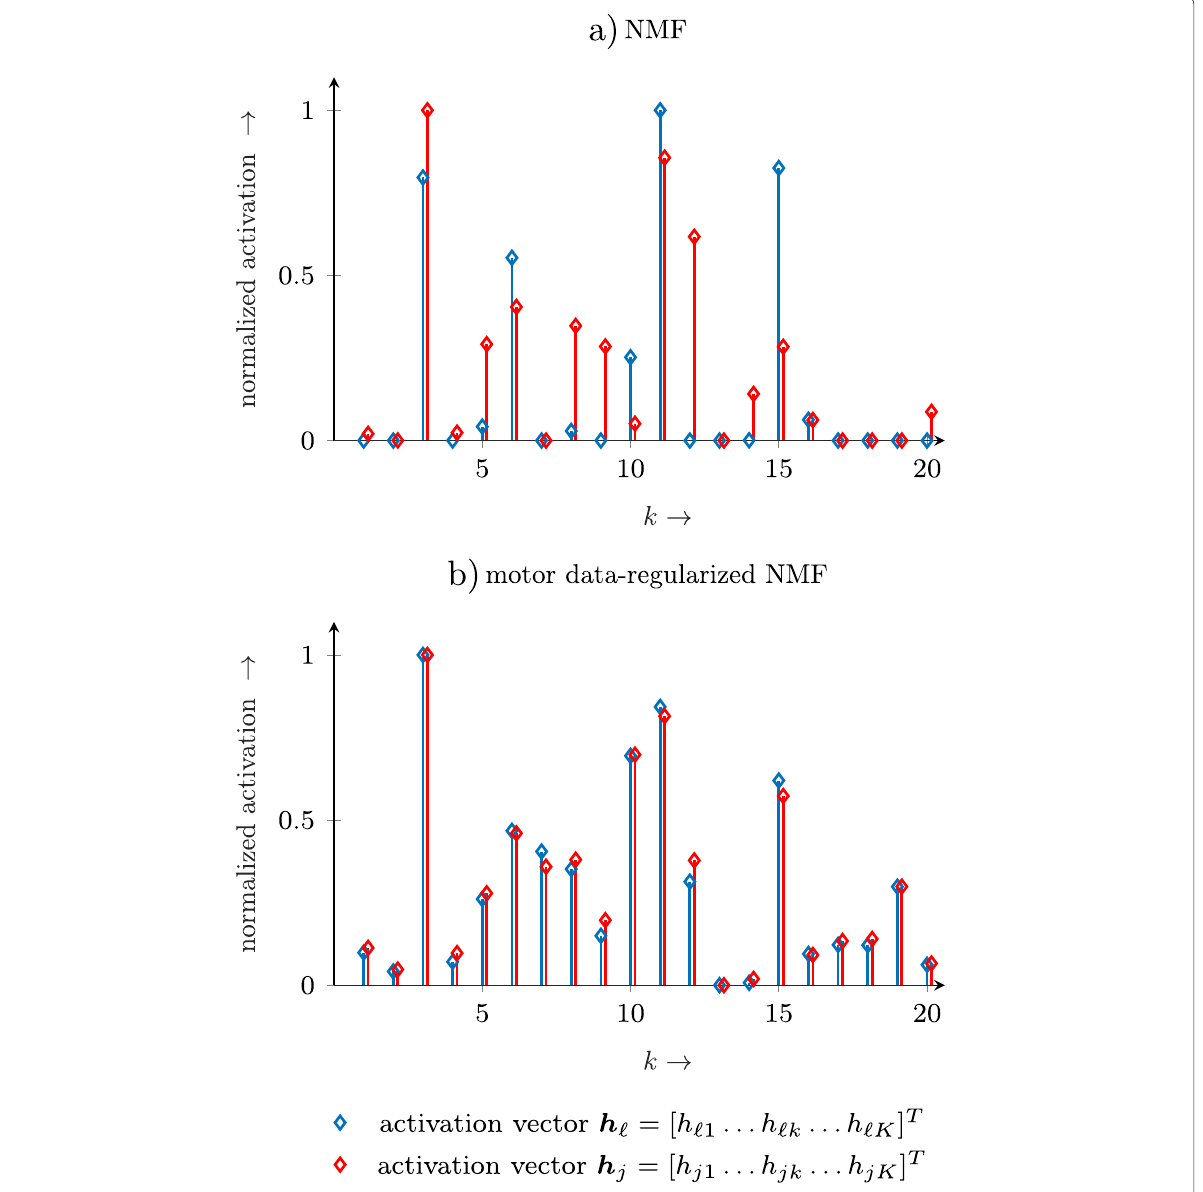
Fig. 6 Estimated ego-noise activations by a NMF and b motor data-regularized NMF for time frames (cid:2) and j , where (cid:2) and j were chosen such that W (cid:2) j is large (here W (cid:2) j ≈ 0.9). The considered mixture of ego-noise (Sequence I) and speech has SNR = 3 dB, dictionary sizes K = 20 and K S = 20. For motor data-regularized NMF, λ T = 0.9, λ E = 19 were